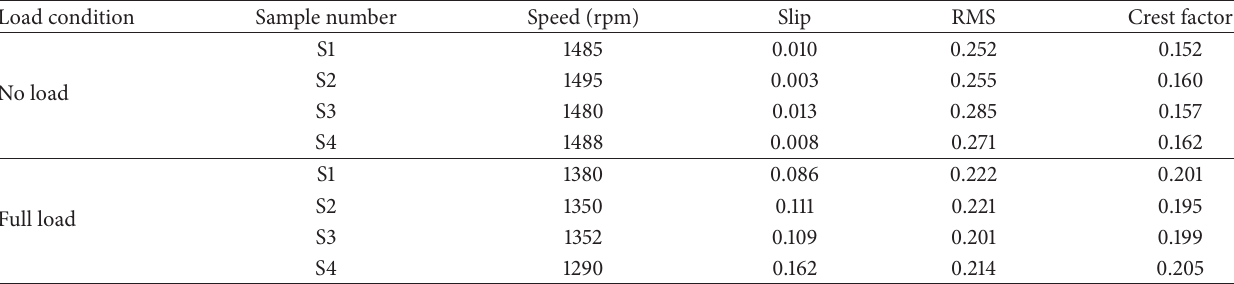
Table 3: Measured fault frequencies at various load